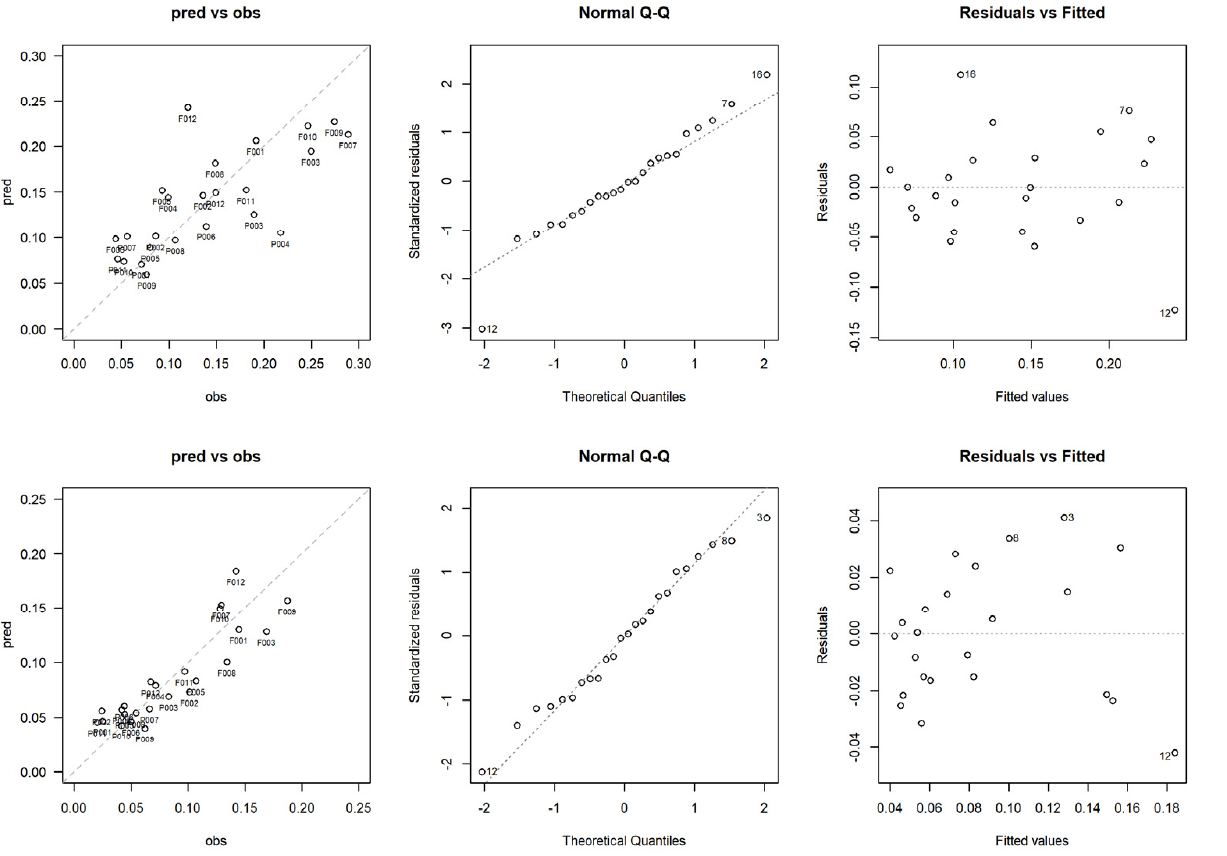
Figure 5. Regression graphs for the estimation of the lower (LU, first line) and upper understory (UU, second line).